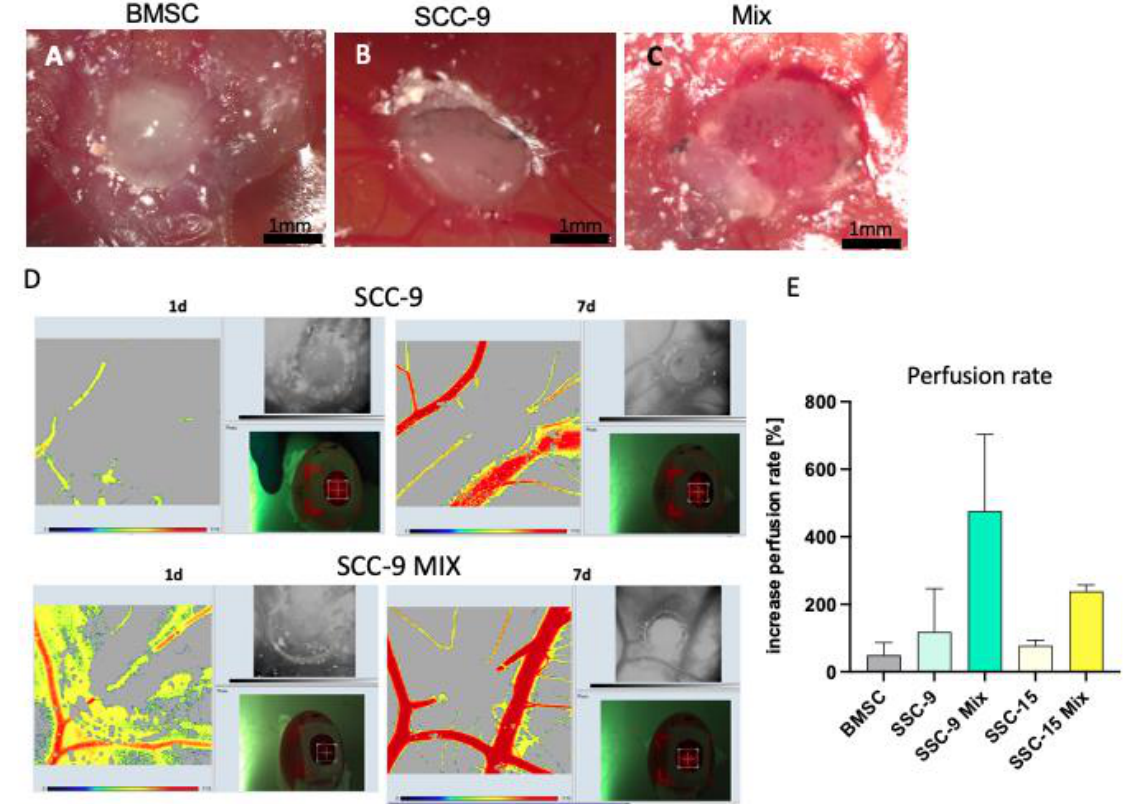
Figure 1. ( A – C ): An exemplified image of BMSC, HNSCC (SCC-9), and BMSC/HNSCC co-culture 3D spheroids (mix) placed on the chorioallantoic membrane (CAM) of a chicken egg. After 7 days, all heterogeneous co-cultures showed markedly increased neoangiogenesis and visible ingrowing blood vessels. In contrast, the homogeneous spheroids did not exhibit neoangiogenesis or ingrowing blood vessels. ( D ): Exemplified images of LSCI measurements. Measurement of perfusion revealed greatly increased blood flow in the co-cultures within 7 days ( D , E ). n = 3. HNSCC: head and neck squamous cell carcinoma cell lines, BMSC: bone marrow-derived stromal cells, mix: co-culture of BMSCs and HNSCC cells. Bar = 1 mm.